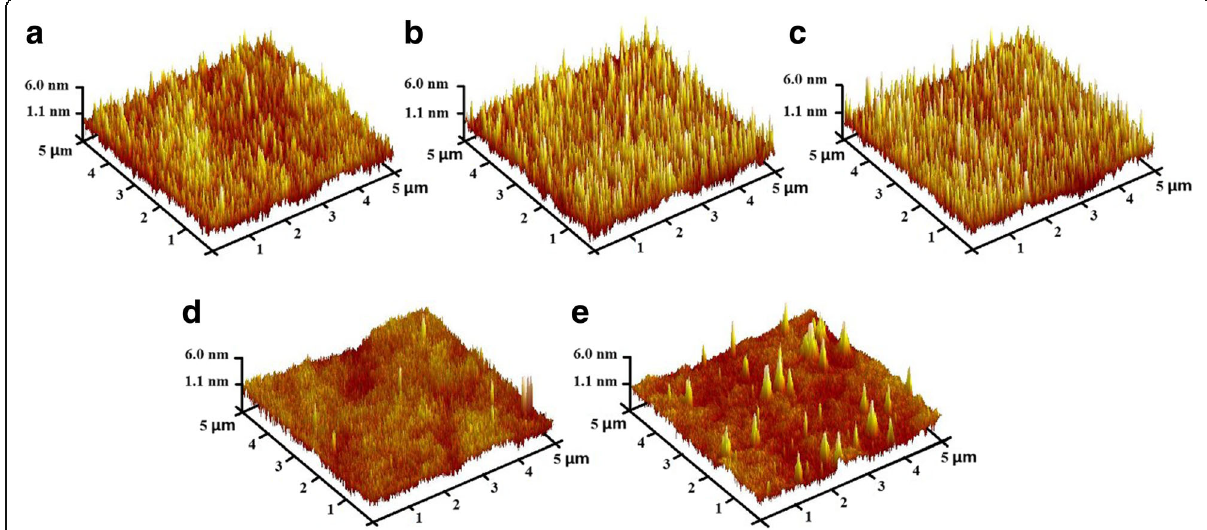
Fig. 3 AFM 3D images of nanolaminates with different bilayer thicknesses: a 2 (25/25 nm), b 5 (10/10 nm), c 10 (5/5 nm), d 25 (2/2 nm), and e 50 (1/1 nm)